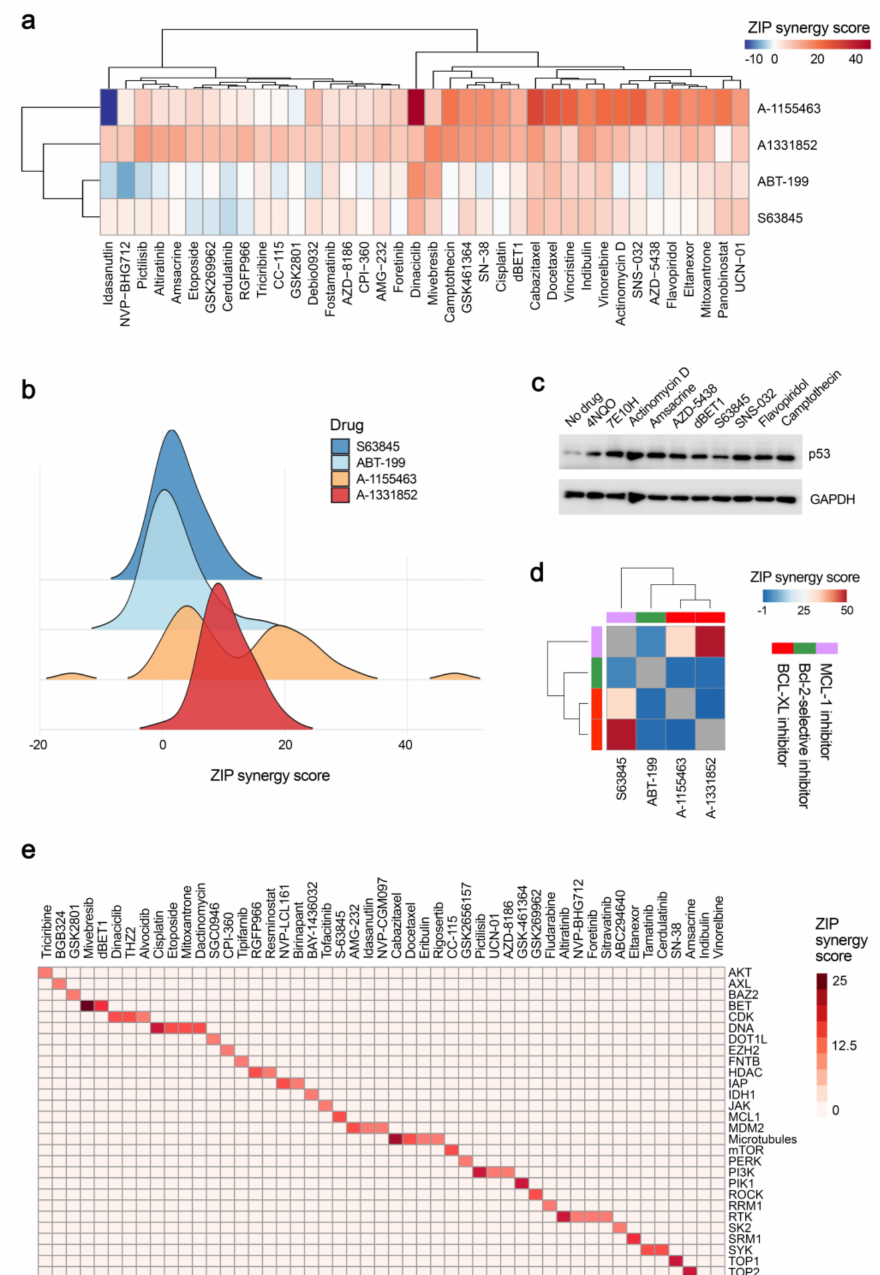
Figure 6. Identification of anticancer agents, which trigger Bcl-xL-mediated apoptosis. ( a ) Heatmap showing synergy scores for combinations of four Bcl-2 inhibitors and 39 anticancer agents. RPE cells were treated with 0, 10, 30, 100, 300, 1000, 3000 and 10,000 nM Bcl-2 inhibitors and anticancer agents. After 24 h cell viability was measured by the CTG assay. ( b ) Distribution of synergy scores based on (a). ( c ) Immunoblot analysis of p53 and GAPDH (loading control) expression levels after 2h of treatment of RPE cells with selected anticancer agents. ( d ) Heatmap showing synergy scores for combinations of four Bcl-2 inhibitors with each other. RPE cells were treated with 0, 10, 30, 100, 300, 1000, 3000 and 10,000 nM Bcl-2 inhibitors. After 24 h cell viability was measured by the CTG assay. ( e ) Cellular targets of anticancer agents which showed synergy with A-133852. RPE cells were treated with A-133852 and 527 anticancer agents as for panel (a). After 24 h cell viability was measured using the CTG assay. The compounds with synergy > 7.5 were selected and plotted against their targets. ZIP method was used to calculate synergy scores for all